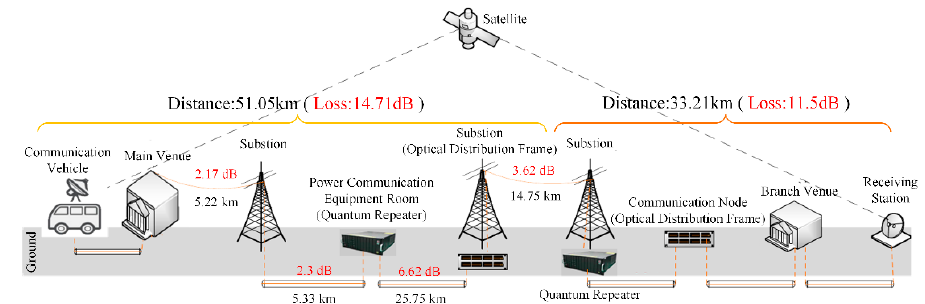
Figure 9. Video conference system based on